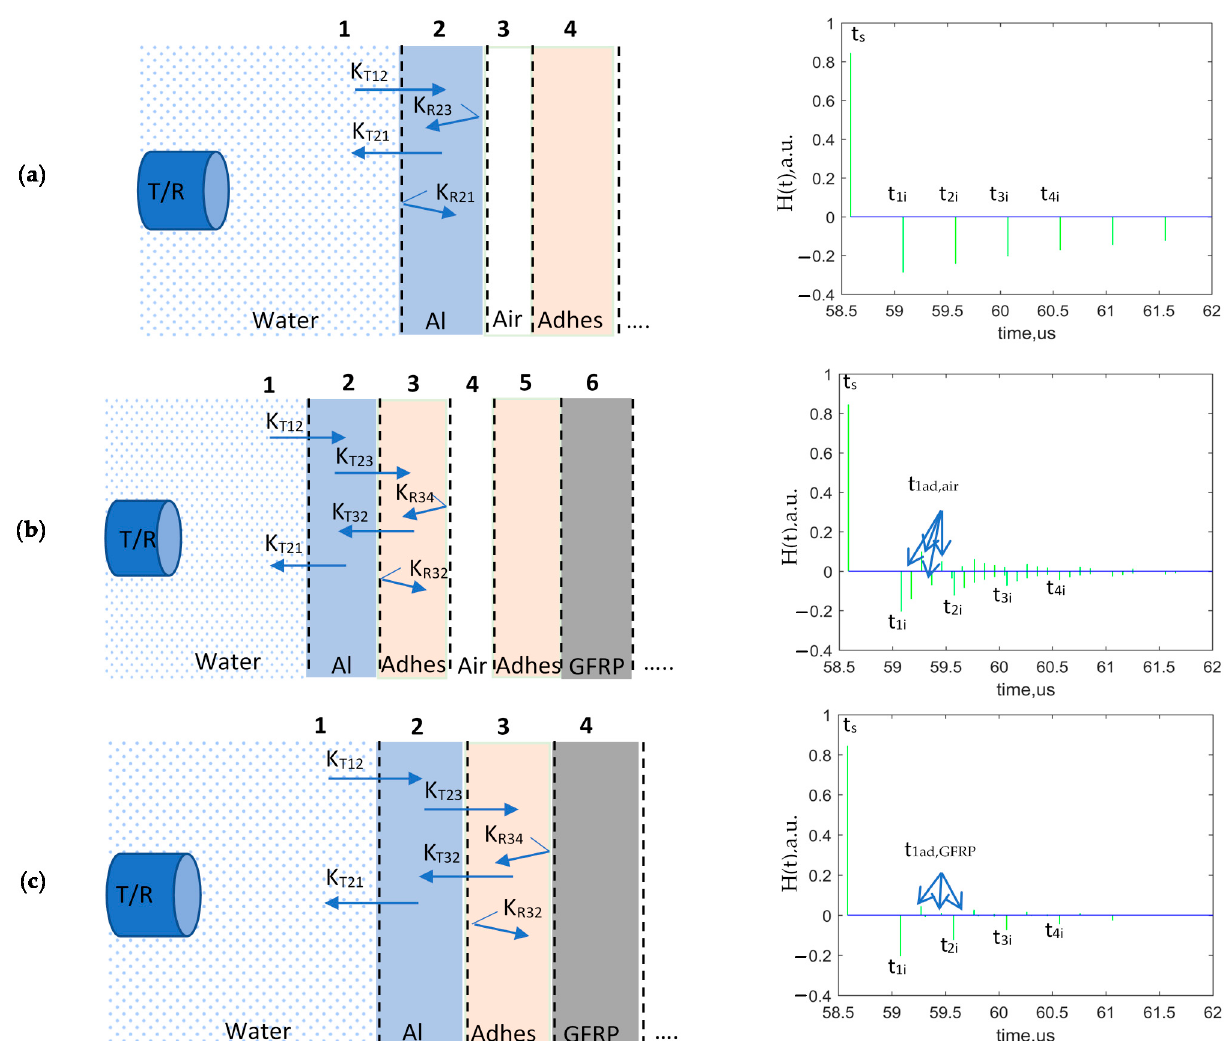
Figure 7. Three different cases of analyzed boundary conditions: ( a ) Total debonding between aluminum and adhesive layer; ( b ) Total debonding in adhesive layer; ( c ) Perfect bonding. The layers of the sample are presented not in scale.